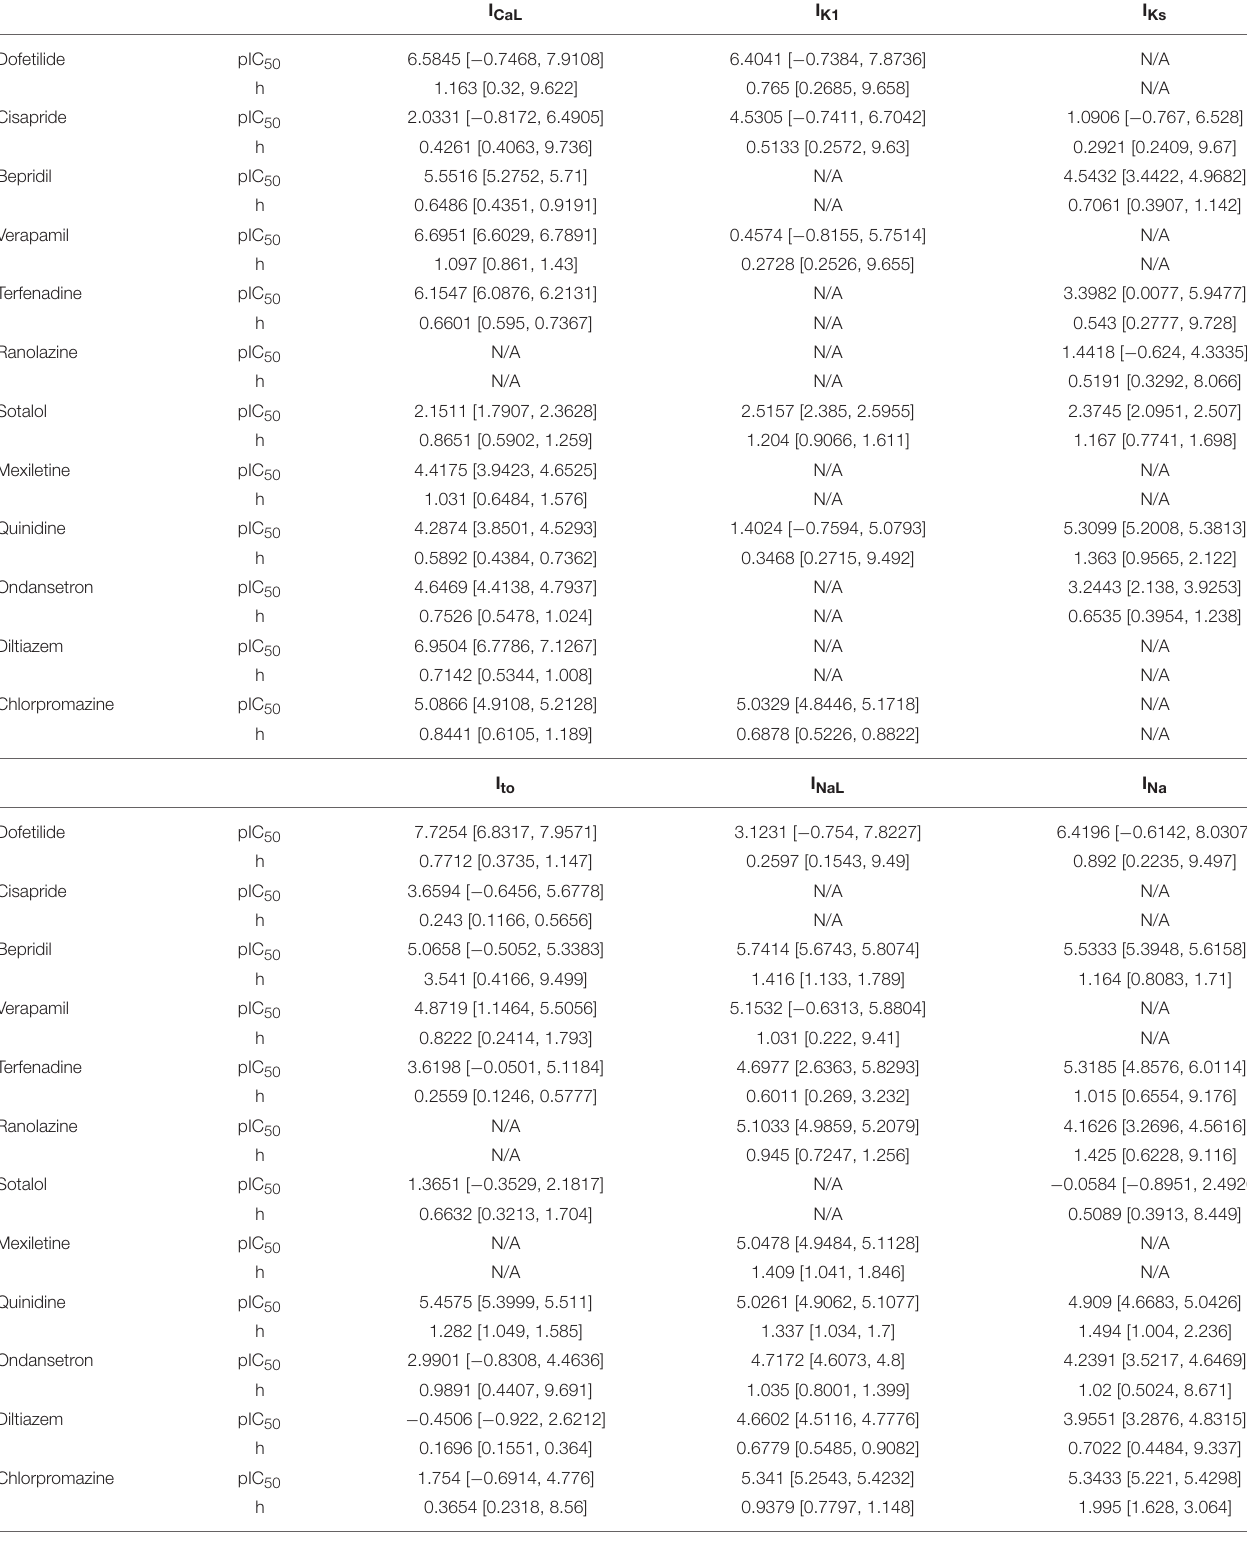
TABLE 3 | Hill equation parameters for the 12 CiPA training